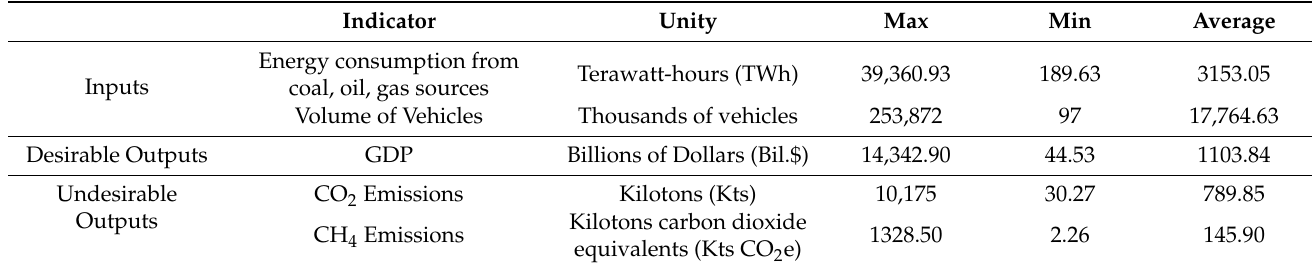
Table 3. Statistical study of inputs and outputs for the 20 top Asian economies in 2005–2019.